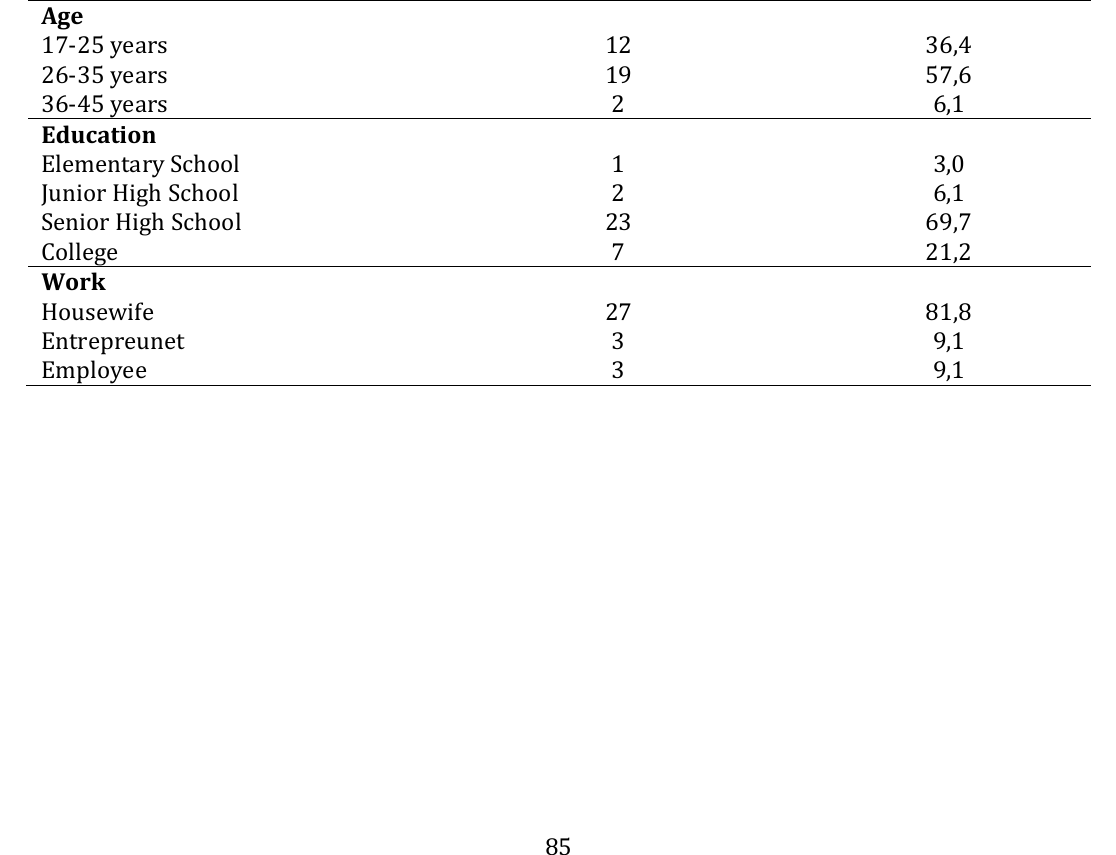
Frequency Distribution of Respondents Characteristics